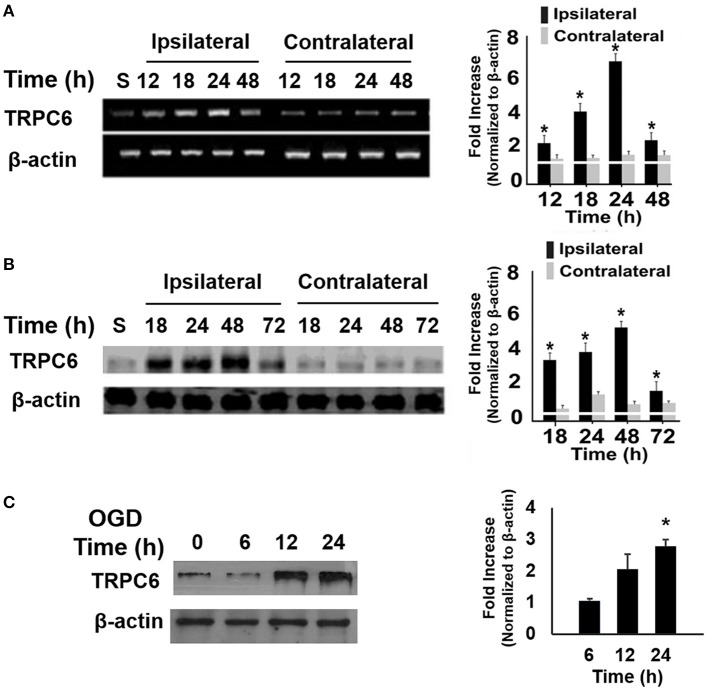
Ischemia/Reperfusion (I/R) and OGD increased TRPC6 expression. (A,B) Time course analysis of TRPC6 mRNA (A) and protein (B) expressions in the ipsilateral and contralateral cortices of mice subjected to I/R. Quantitative analyses of the changes in TRPC6 mRNA and protein levels at the indicated time points after I/R were determined by densitometry. Fold increases are relative to Sham (S). *P < 0.01 compared to corresponding values in the contralateral cortices (n = 4/group). (C) TRPC 6 protein in WT cortical neurons subjected to OGD. Immunoblotting was performed with 50 μg of total proteins and probed with antibodies to TRPC6. β-actin was used as a loading control. Three independent experiments at each time point (n = 3). *P < 0.01, compared with control groups (0 h).